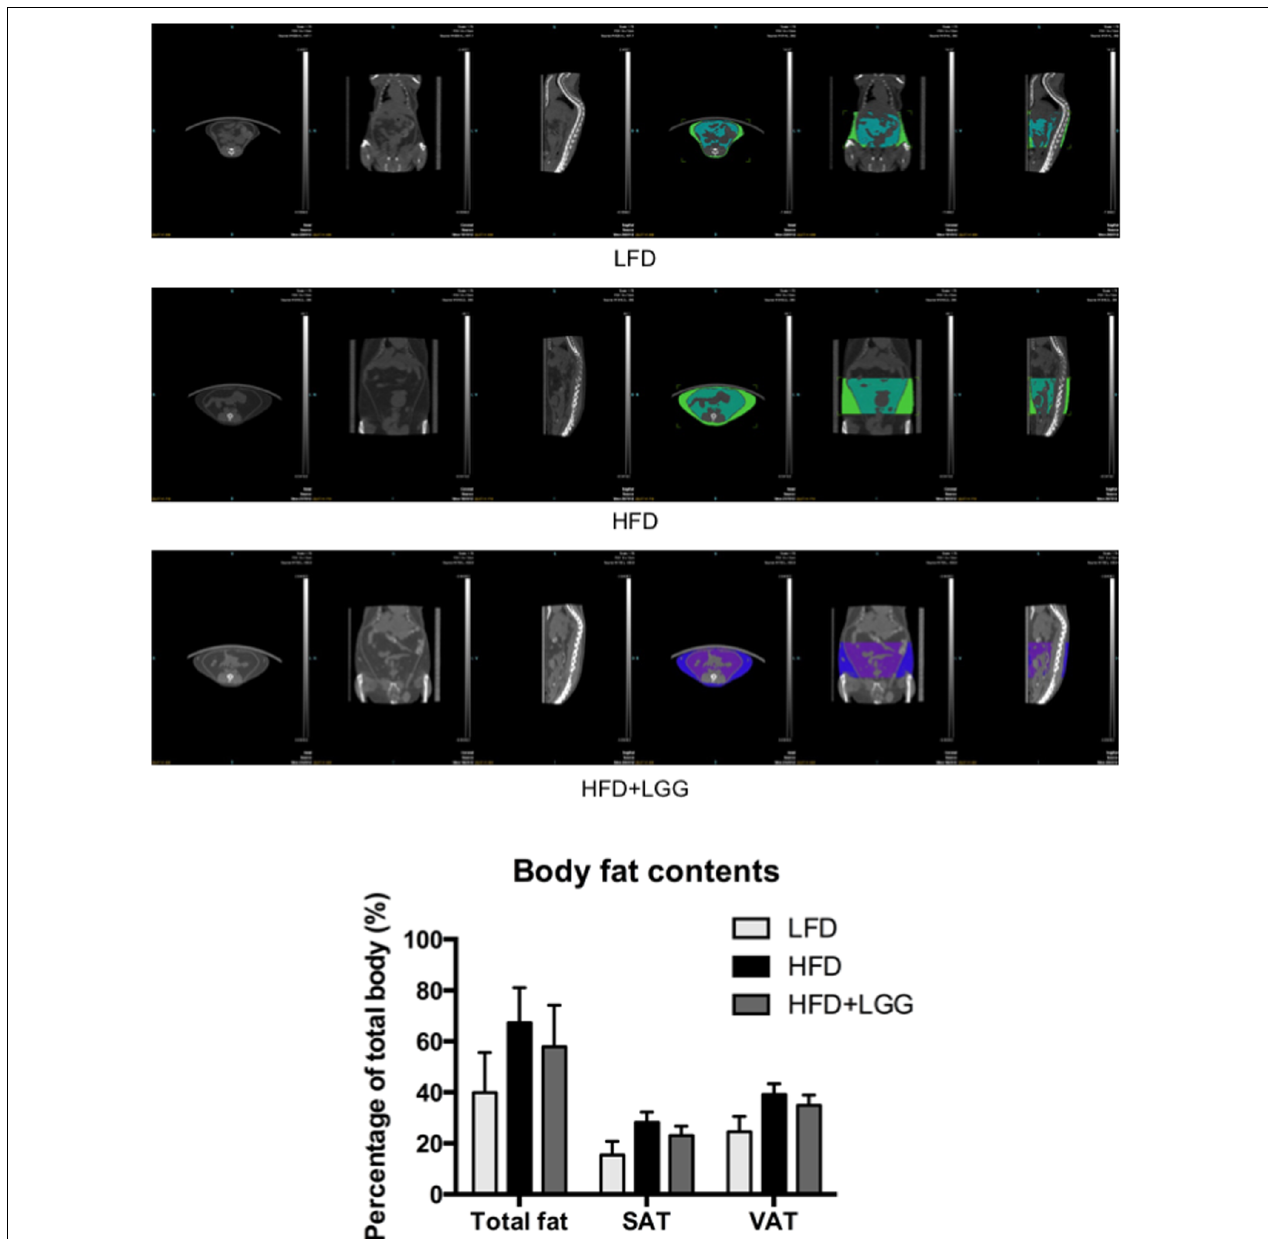
FIGURE 2 | Pictures of micro-CT of each group. Fat mass was measured between lumbar numbers 1–6; visceral adipose tissue (VAT) and subcutaneous adipose tissue (SAT) were visualized and measured in different colors. Fat mass was first calculated in volume (mm 3 ) to indicate its percentage out of total body volume using Inveon